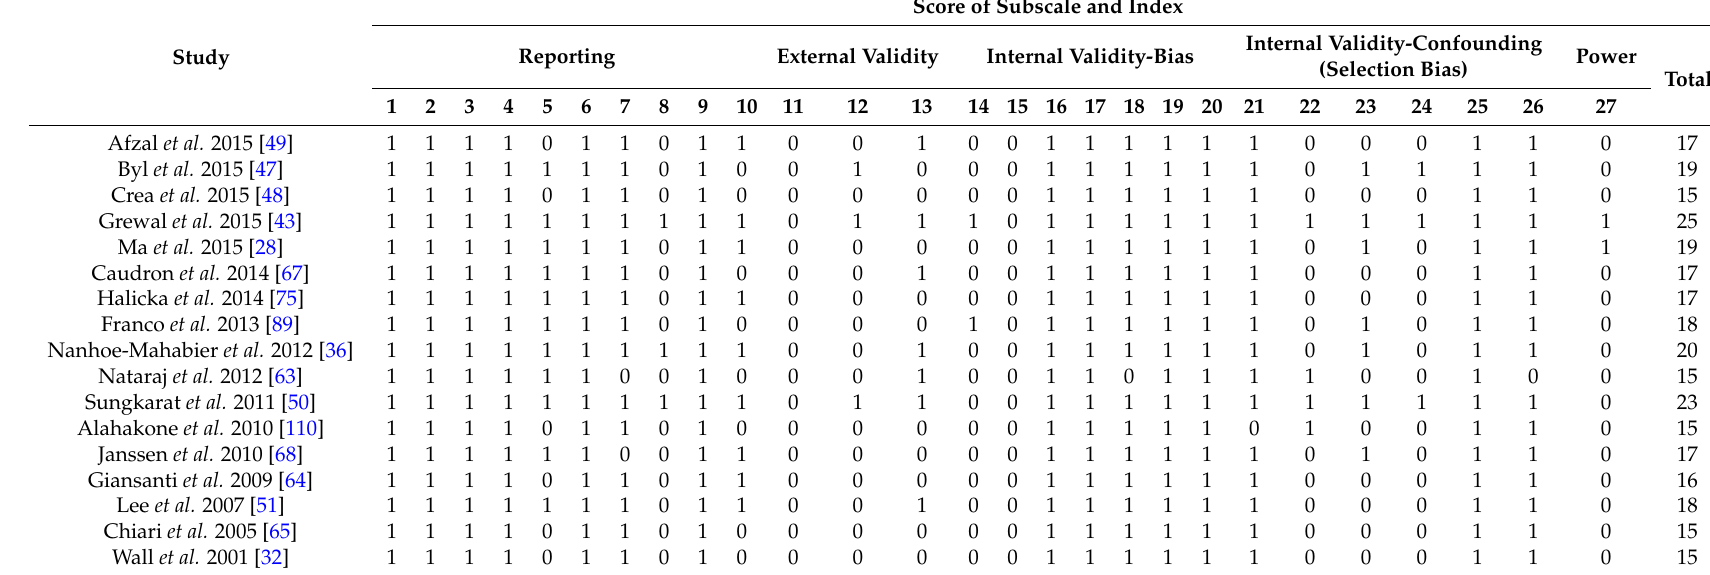
Table 6. Assessing results of the Downs and Black Quality List ( n =